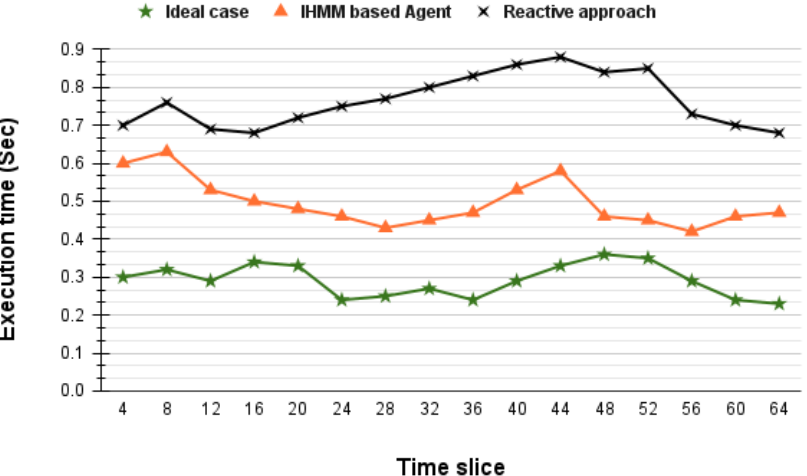
Figure 8. Comparison of three cases execution.